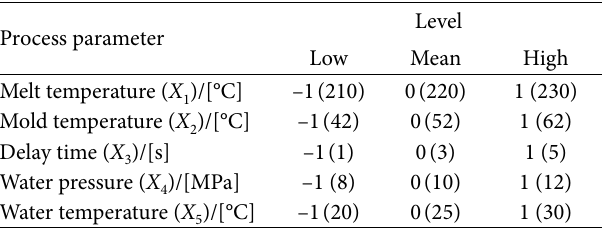
Table 1: Factors and level of process